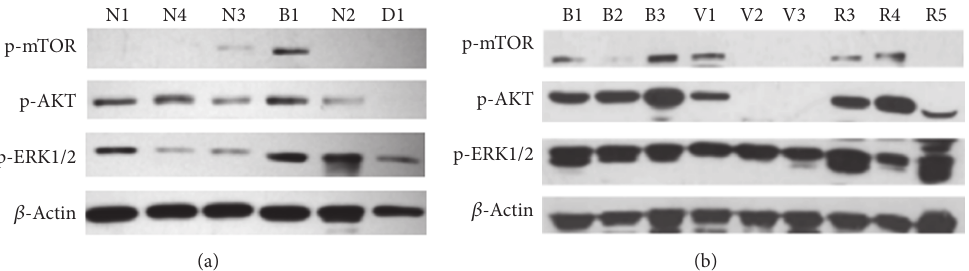
Figure 1: Phosphorylation of AKT, ERK1/2, and mTOR in PPGL tissues. (a) Phosphorylation of AKT, ERK1/2, and mTOR in 6 PPGLs used in in vitro experiments. (b) Phosphorylation of AKT, ERK1/2, and mTOR in 9 PPGLs from patients with different gene mutations. 𝛽 -Actin was used as a loading control. N: PPGL without gene mutation of SDHB, SDHC, SDHD, VHL, and RET; B: PPGL with SDHB mutation; D: PPGL with SDHD mutation; V: PPGL with VHL mutation; R: PPGL with RET mutation.